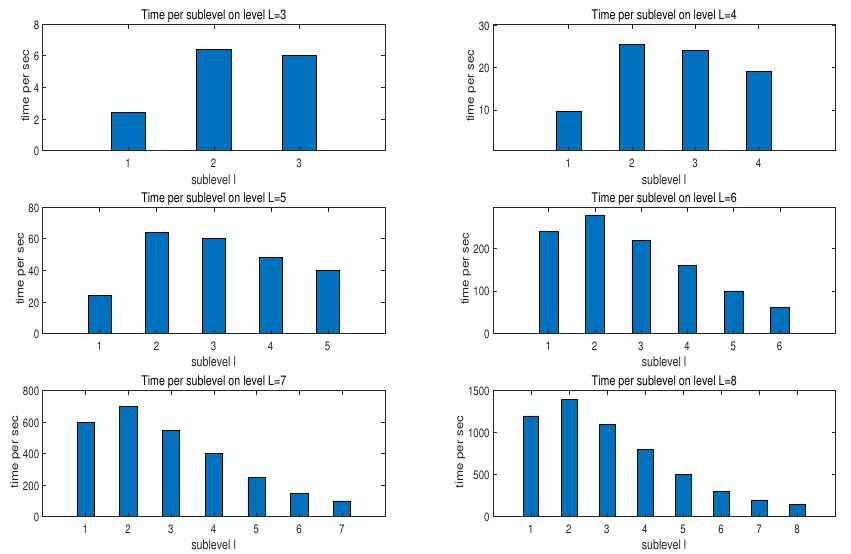
Figure 3. CPU time for different levels for the MLMC-HDG approximation of E L ( u ) and E L ( q )